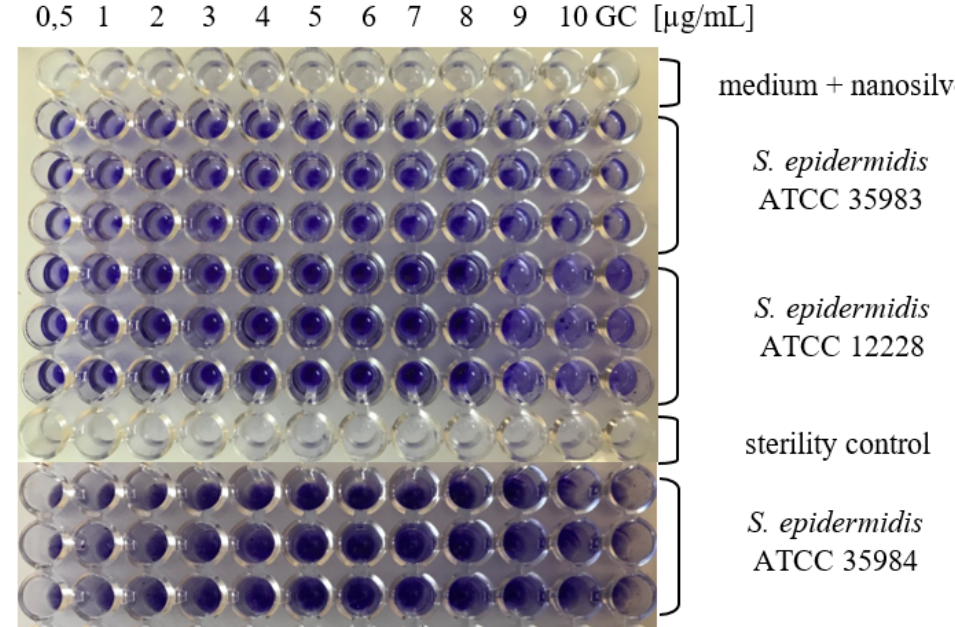
Figure 2. Assessment of BFA of S. epidermidis strains exposed to various concentrations of AgNPs, particle size 10 nm. From top to bottom, in rows: row 1: Tryptic Soy Broth (TSB) medium + nanosilver; rows 2–4: TSB medium + nanosilver + standard strain S. epidermidis ATCC 12228, rows 5–7: TSB medium + nanosilver + standard strain S. epidermidis ATCC 35983; row 8: TSB medium (sterility control); rows 9–11: TSB medium + nanosilver + standard strain S. epidermidis ATCC 35984. GC- growth control.